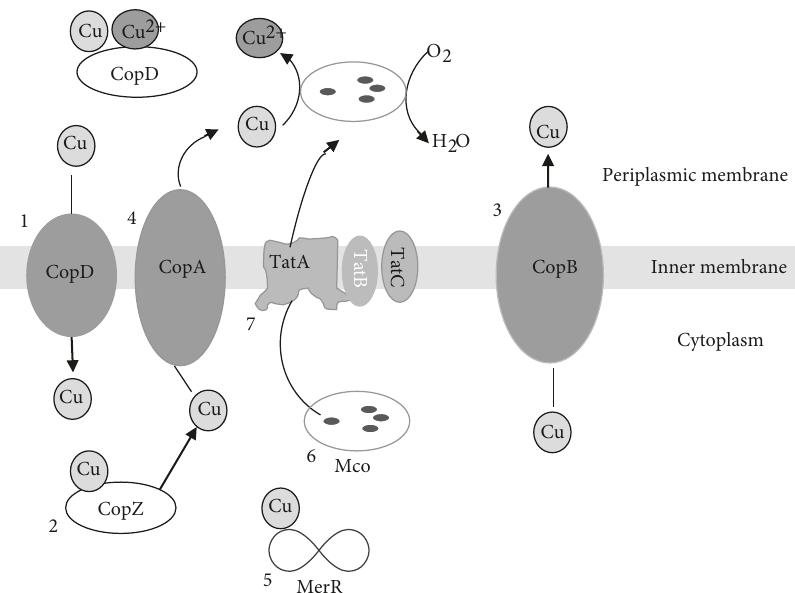
Figure 6: Proteins involved in the copper homeostasis of Arthrobacter sp. PAMC25284. The proteins are depicted in the schematic. The proteins are labeled with their name. The information is denoted as follows: 1, copper entry into the cytoplasm; 2, copper sequestration by metallochaperones; 3 and 4, copper secretion by ATPases; 5, cytoplasmic copper complexed with MerR to induce and express CopA copper efflux ATPase, the multi-copper oxidase; 6, MCO/MmcO, multi-copper oxidase domain-containing protein translocated to the periplasm by the twin-arginine translocation system (TatABC), probably as a folded